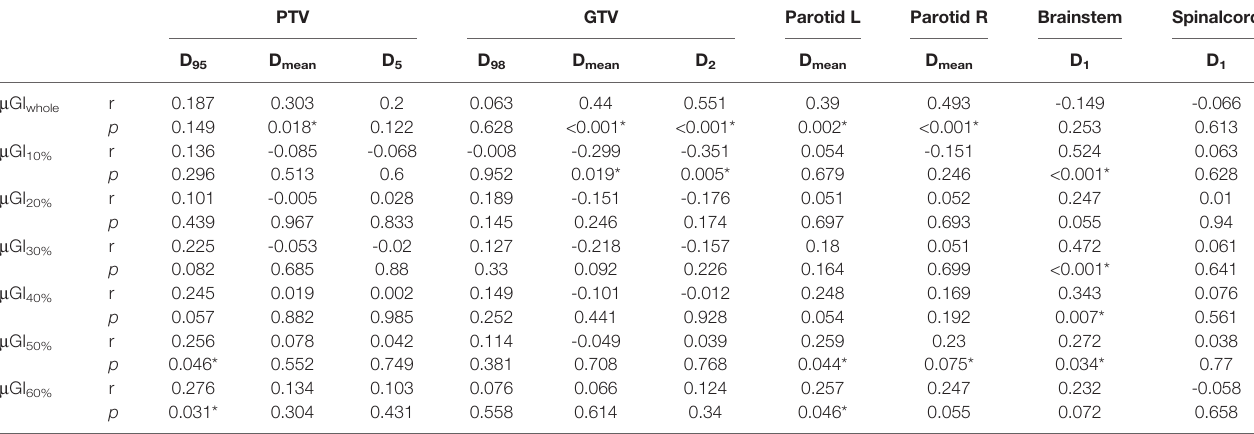
TABLE 2 | The correlation between the %DE and the m GI in different regions for NPC patients. PTV